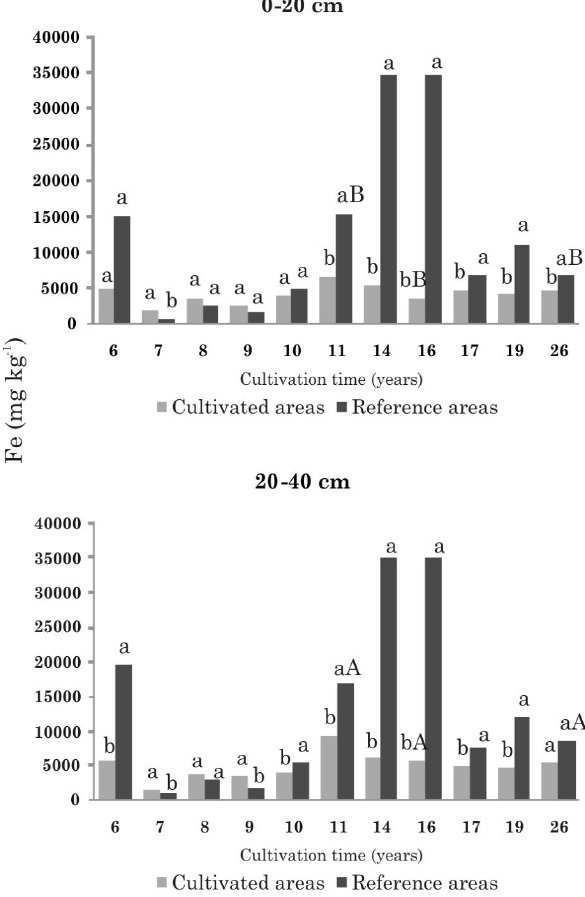
Figure 4. Total contents of Mn in cultivated (CA) and reference areas (RA) in two layers (0-20 and 20- 40 cm) after different cultivation periods. Means followed by lowercase letters between environments (CA and RA) and capital letters between layers (0-20 and 20-40) did not differ statistically by Tukey’s test (p (cid:172)(cid:31)(cid:172) 0.05).